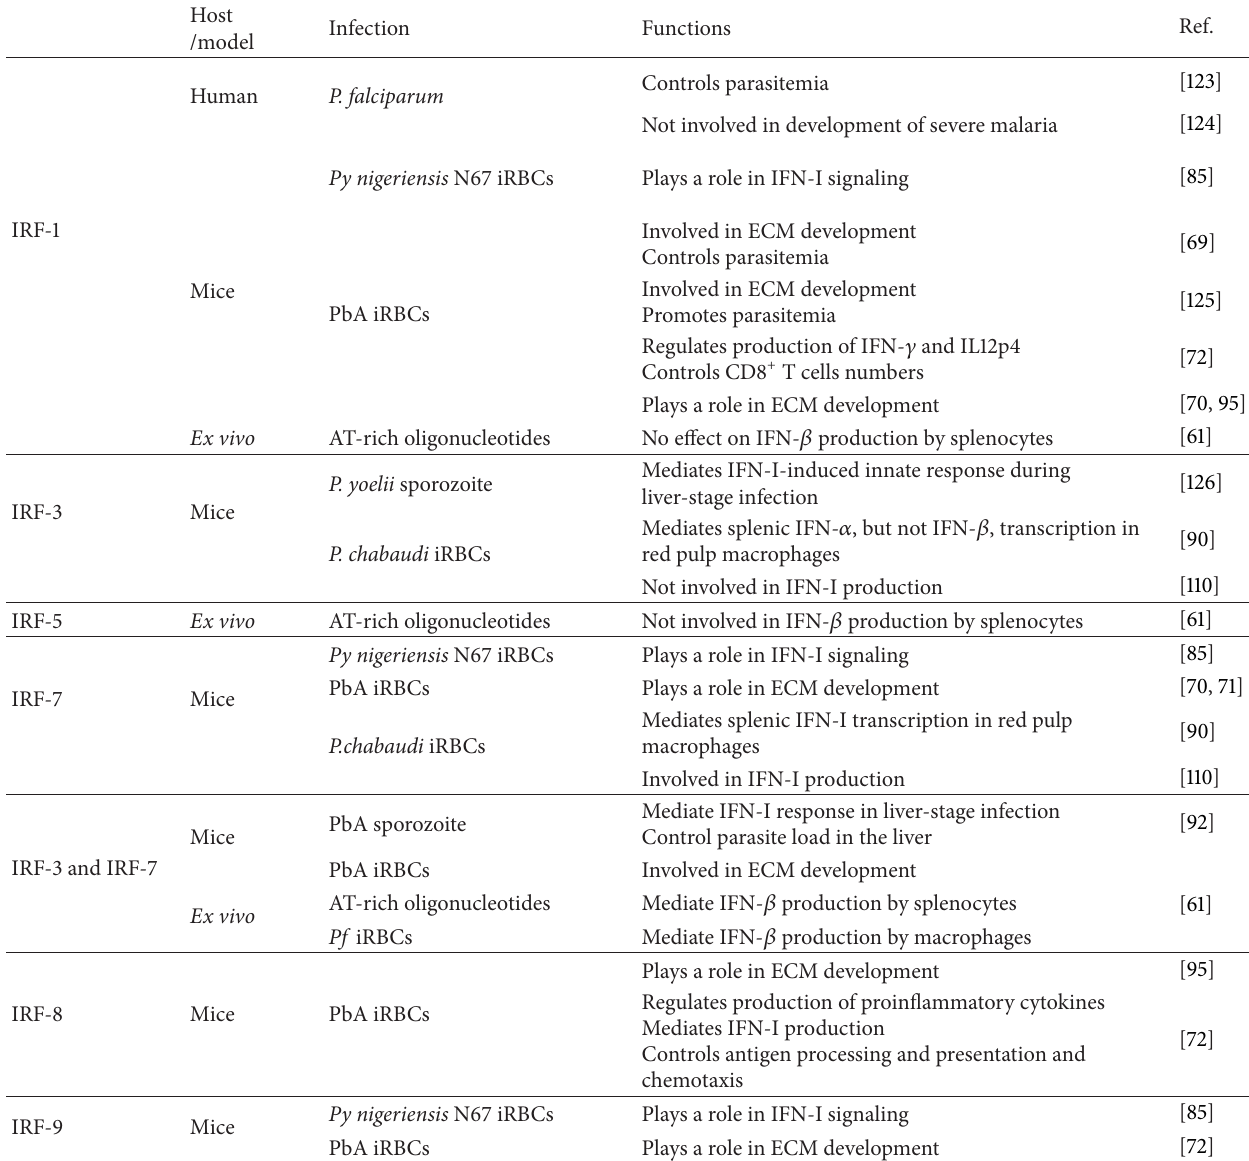
Table 4: Diverse roles of different IRFs in malaria infection.